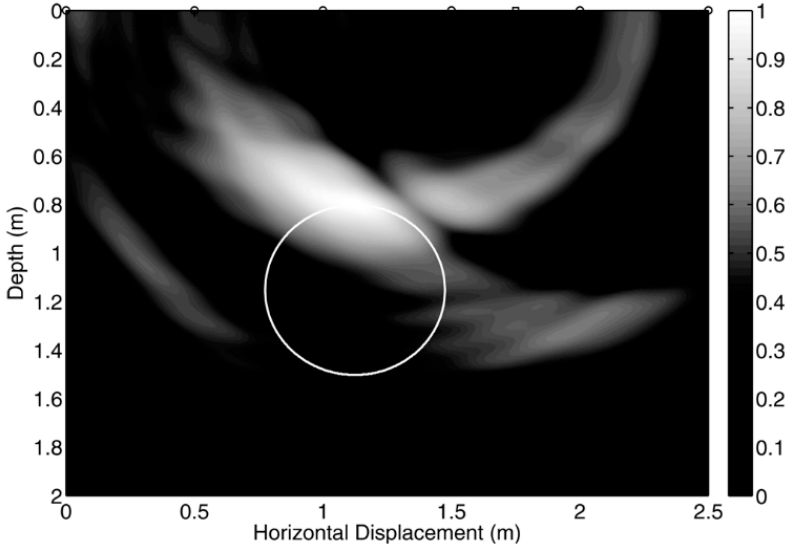
Figure 13. Cross-sectional image produced from compressional wave method. The white bold line shows the location of the target [101], Copyright AIP Publishing, 2011.